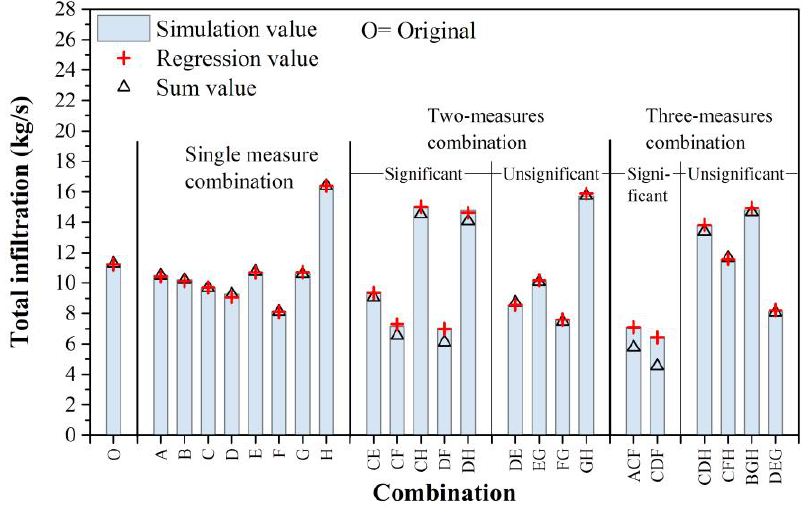
Figure 11. The total infiltration: the contrasts of regression and sum values. Based on the results of the regression model, all combinations were listed, and the effects on total infiltration were calculated. As shown in Figure 12, the candidate combi- nations are arranged in order from the highest reducing level to the lowest, and the alias factors are repaired. There are 45 combinations of not exceeding three measures that have a reducing effect on total infiltration. The highest reduction appears to be 45.3% due to